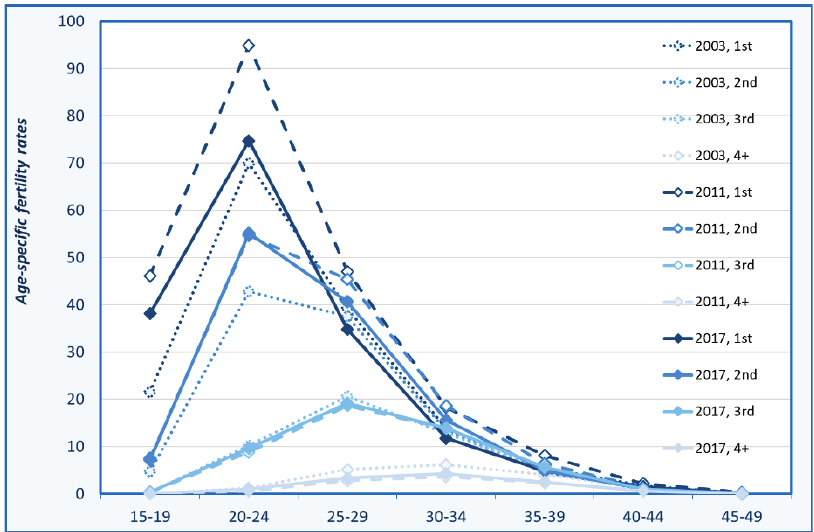
Figure 10. Dynamics of age-specific specific fertility rates by birth order in Azerbaijan. Source: ac- cording to SSC